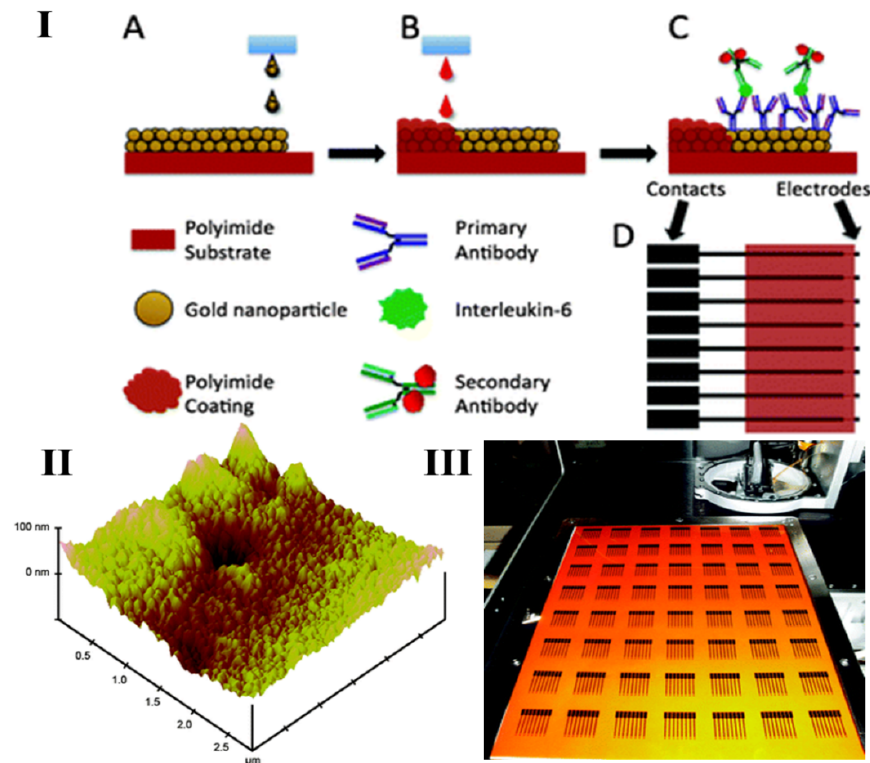
Figure 13. The inkjet-printed electrode immunoassay. ( I ) Schematic diagram of the immunoassay procedure indicating ( A ) AuNP inkjet printing on to the Kapton polyimide substrate, ( B ) insulation with poly(amic) acid, ( C ) immunoassay build-up, and ( D ) the electrode surface with AuNP patterns in black and insulating poly(amic acid) patterns in orange. ( II ) Tapping mode Atomic Force Microscopy (AFM) image of the AuNP working electrode surface. ( III ) A total of 56 eight-electrode arrays printed on a Kapton surface by Dimatix Materials Printer. Reprinted with permission from [31], copyright 2012 The Royal Society of Chemistry.